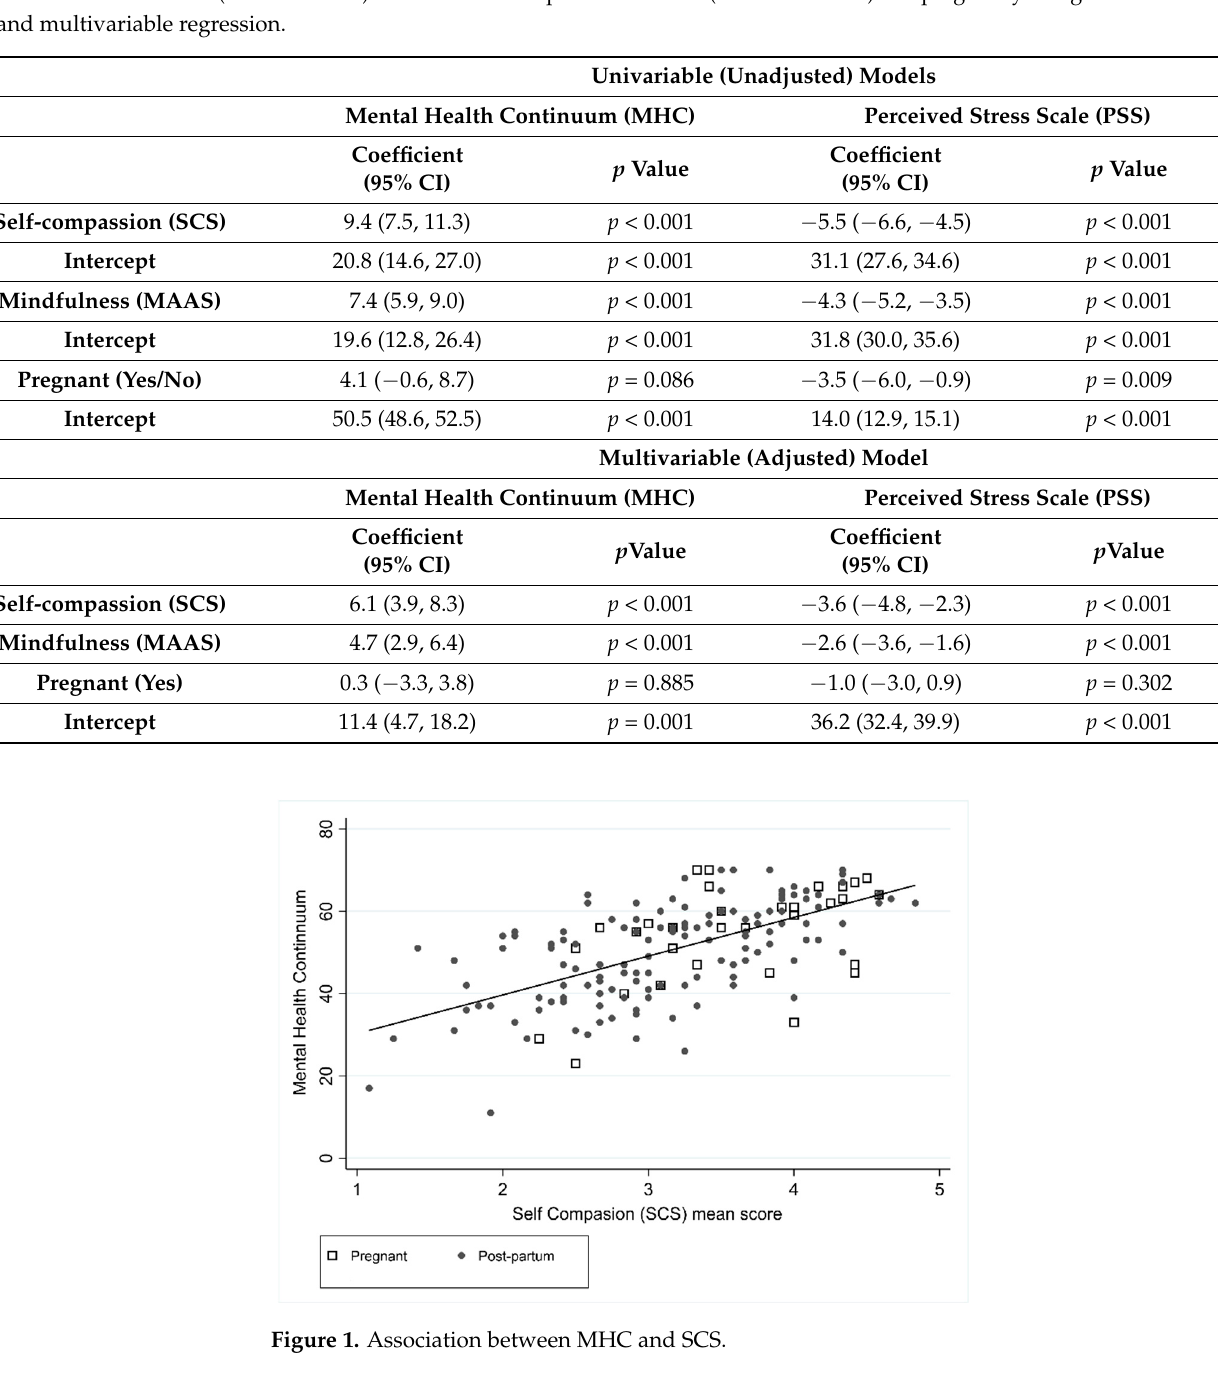
Figure 2. Association between MHC and MAAS.